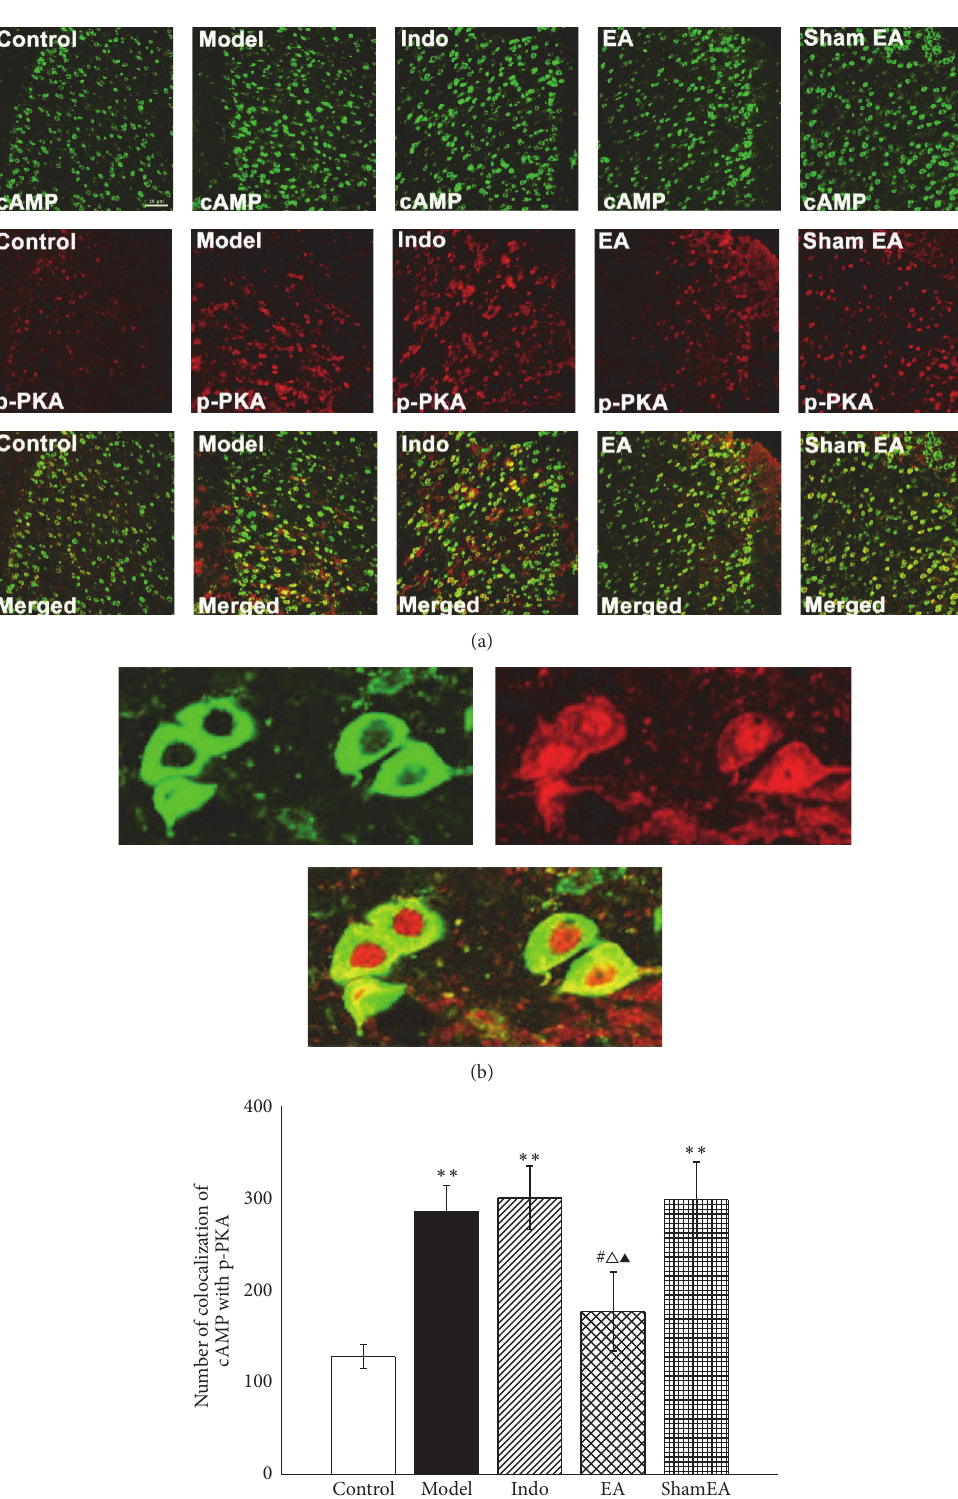
Figure8:EAinhibitedthecolocalizationofcAMPwithp-PKAintheACCofpainmemorymodelrats.TherightACCtissuesfromeachgroup were prepared and labeled with double-immunofluorescence ( 𝑛 = 3 , five slides for each rat). (a) Views of the colocalization of cAMP with p-PKA (scale bar, 20 𝜇 m). (b) The magnified image shows the colocalization of cAMP with p-PKA. (c) Double-labeled immunofluorescence analysis demonstrated that EA significantly reduced the amount of colocalized cAMP and p-PKA. Error bars indicated SEM. ∗∗ 𝑝 < 0.01 , versus the control group; # 𝑝 < 0.05 , versus the model group; △ 𝑝 < 0.05 , versus the indo group; 󳵳 𝑝 < 0.05 , versus the sham EA